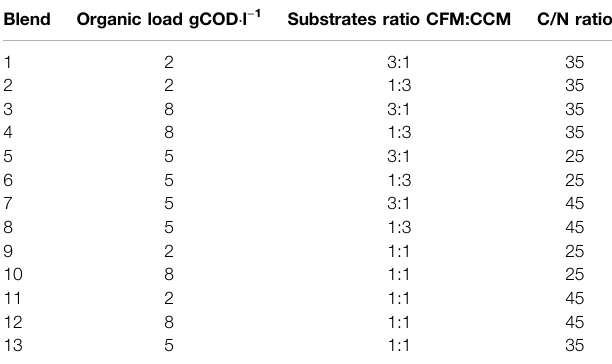
TABLE 2 | Totalorganic loads, CFM:CCM driedmassratios,and C/N massratios of the different blends used for laboratory experiments of AD and DF.